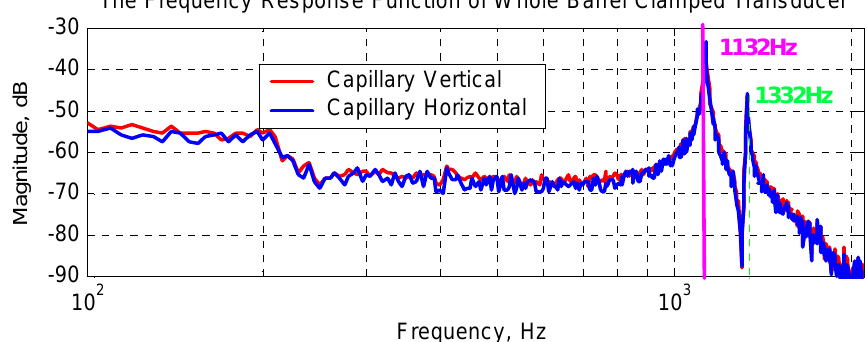
Figure 9. The measured frequency responses of transducer with complete clamping at low frequency range (horn diameter: 13.0 mm, and fixed by four screws on clamper).